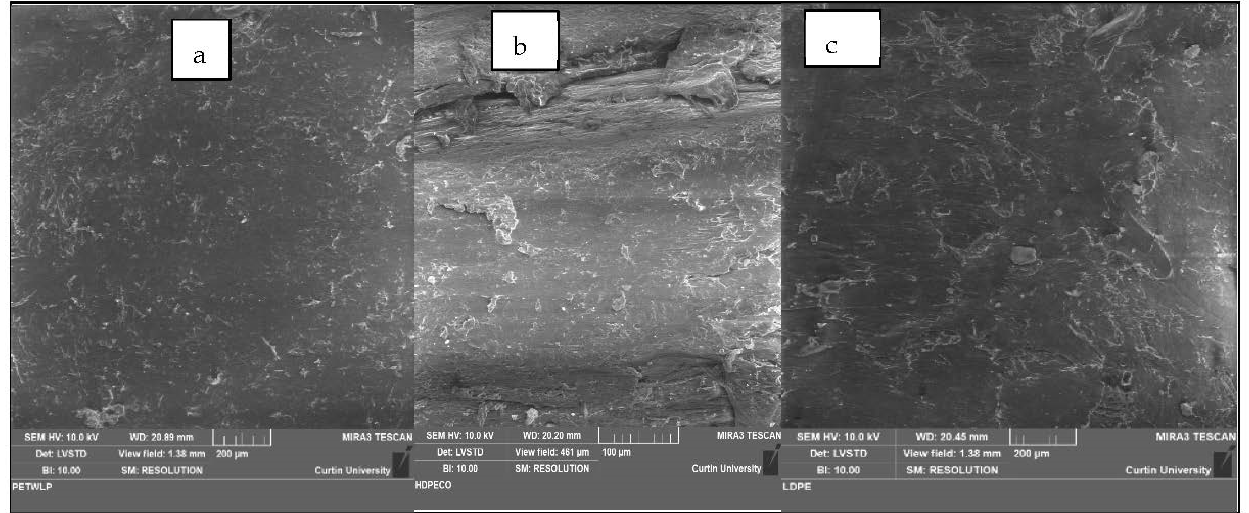
Figure 1. SEM of waste plastic: ( a ) PET, ( b ) HDPE, and ( c ) LDPE.